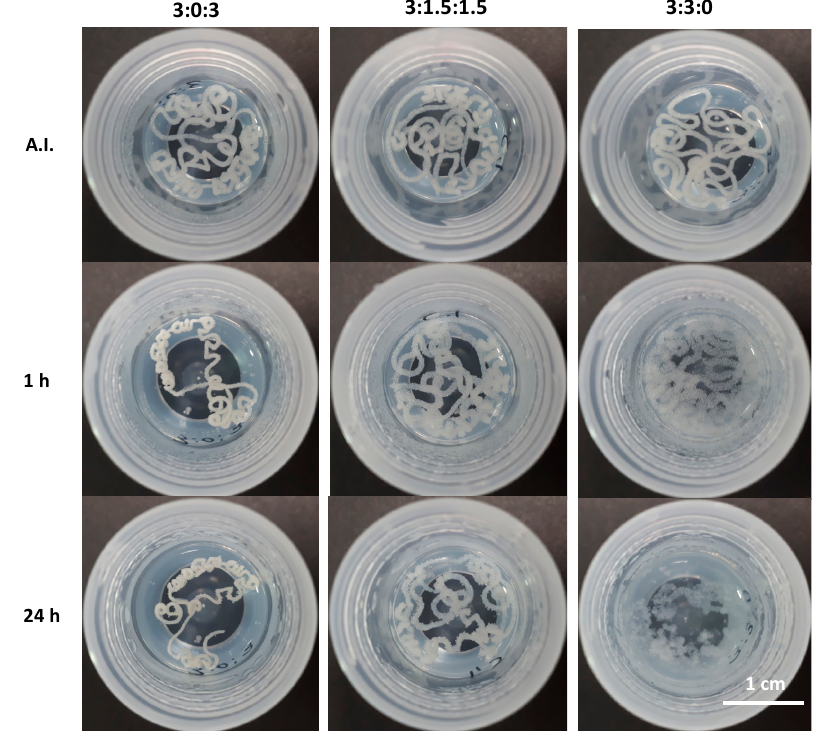
Figure 7. Qualitative evaluation of the integrity and self-healing properties of CHT:PCDi:PCDs hydrogels after injection with an 18G needle in PBS at 37 °C: Immediately after injection (AI) and after 1 h and 24 h of incubation.